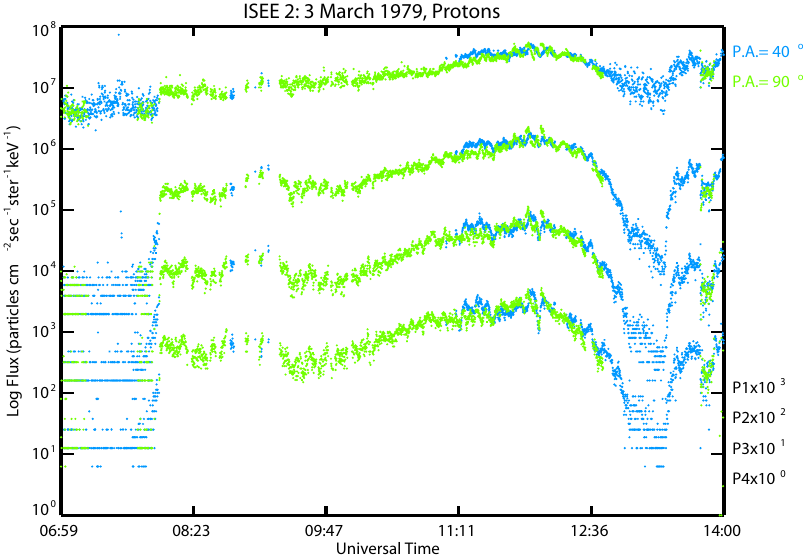
Fig. 9. ISEE-2 proton intensity as a function of time in the channels P1 (17.5–28keV), P2 (28–38keV), P3 (38–48keV), and P4 (48–62keV) observed at 07:00–14:00 UT on 3 March 1979. The pitch angles displayed are 40 ◦ ± 5 ◦ and 90 ◦ ± 5 ◦